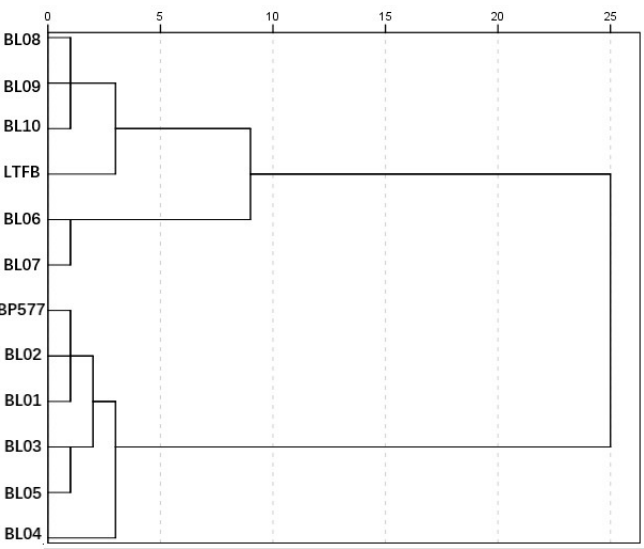
Figure 5. The clustering of genotypes with structural and physicochemical properties.